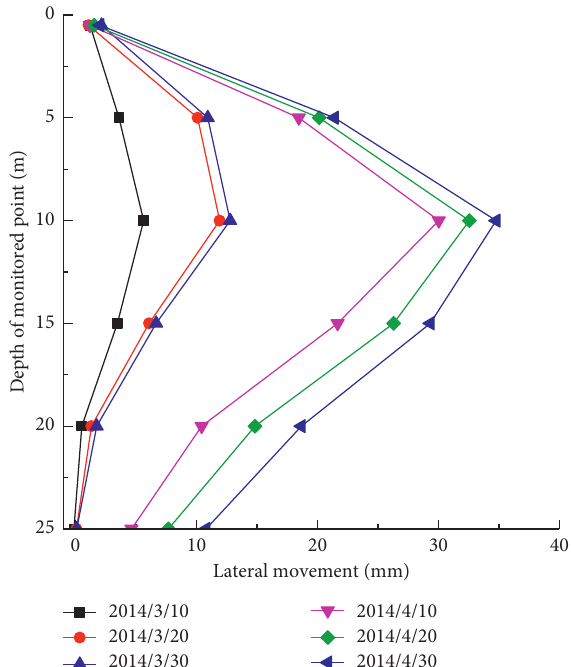
Figure 9: Lateral movement duration curves of point M